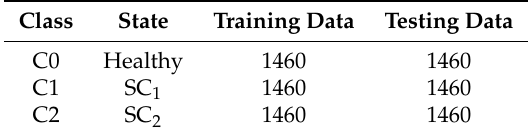
Table 8. Construction of database for fault diagnosis system.